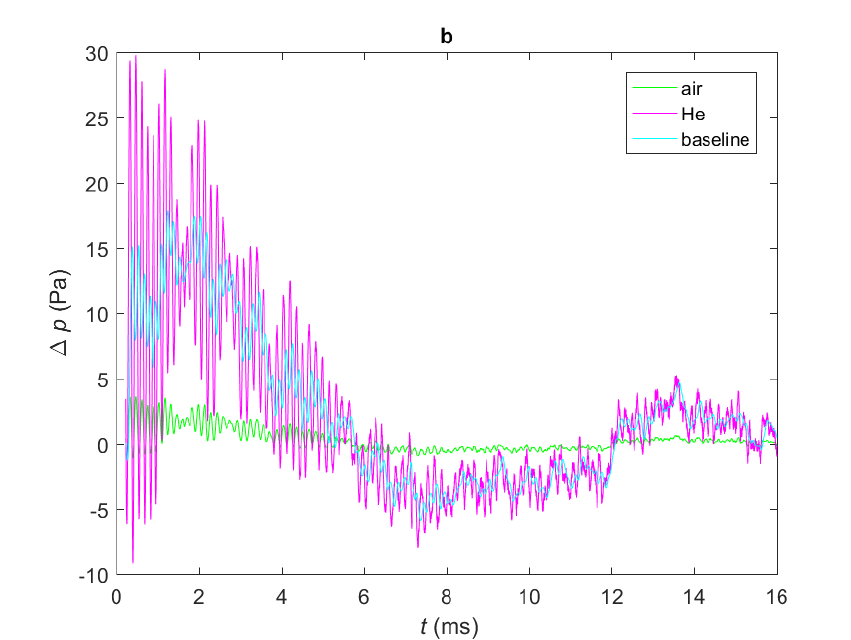
Figure 7. ( a ) Temporal evolution of the relative frequency shift ∆ f / f 1 where the negative values are indicated in red and the positive shifts in black. ( b ) The pressure difference ∆ p for air (green) and He (magenta) required to induce a shift in the resonance frequency as presented in ( a ) are shown. The cyan line indicates the data for He after a second moving average processing step. B. Platier, T. J. A. Staps, C. C. J. M. Hak, J. Beckers, and W. L. IJzerman, Plasma Sources Science and Technology, https://doi.org/10.1088/1361-6595/ab7d8e, 2020; licensed under a Creative Commons Attribution (CC BY) license.